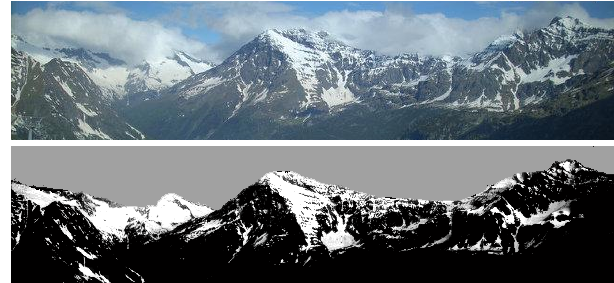
Figure 4. Example of an image (top) and the computed snow mask (bottom), where white stands for snow, black for non-snow, and gray for